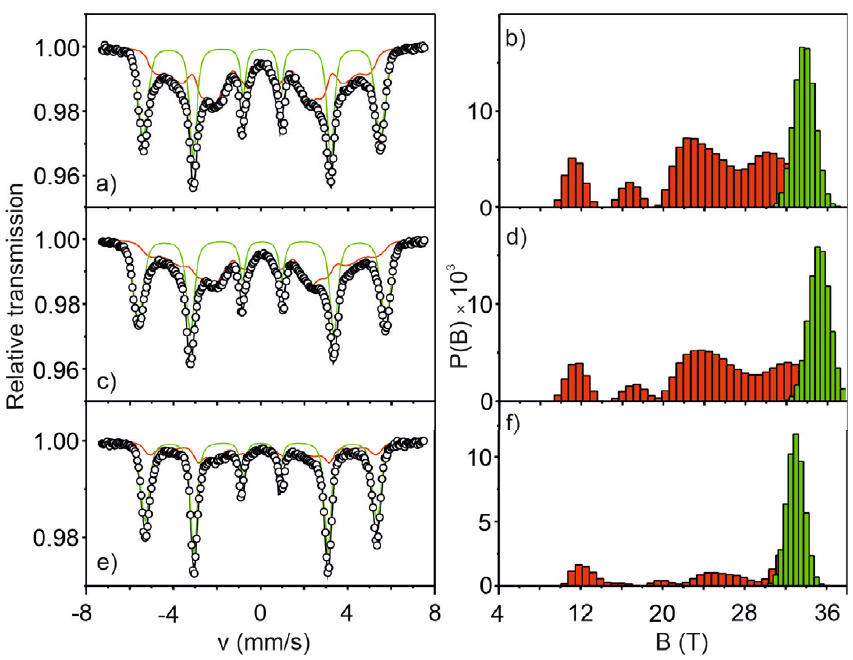
Figure 2. Mössbauer spectra ( a , c , e ) and hyperfine field distributions ( b , d , f ) of Fe 83 − x Co x Nb 3 B 13 Cu 1 (x = 6 ( a , b ), 25 ( c , d ), and 58 ( e , f )) alloys annealed at 750 K for 10 min. Reprinted and adapted from [26] with permission from Elsevier.